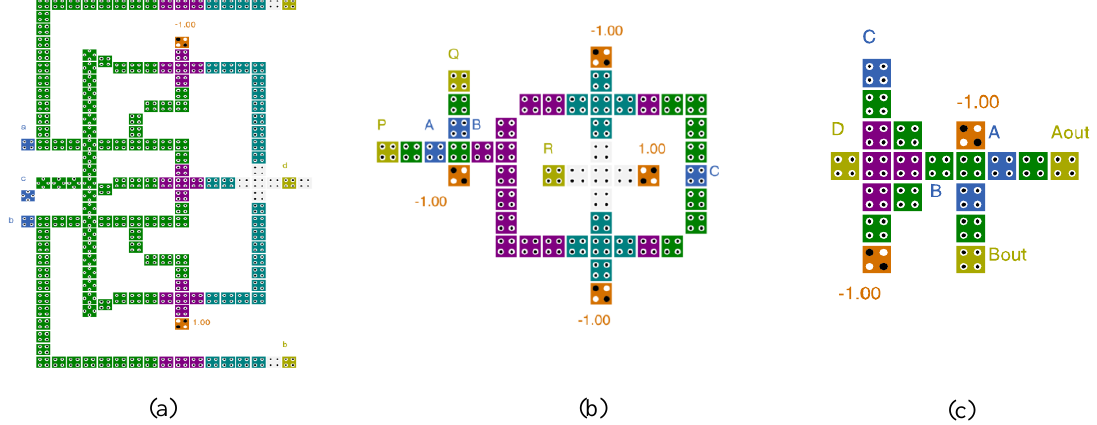
Figure 5. (a) QCA Design of Toffoli in [17] , (b) Toffoli Design in [25], (c) Toffoli Design in